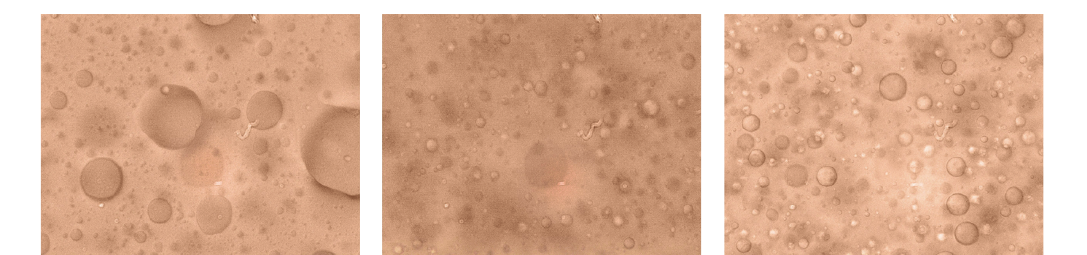
Figure 3: Microstructure of samples BL1, BL2, and BL3 (from left to right).